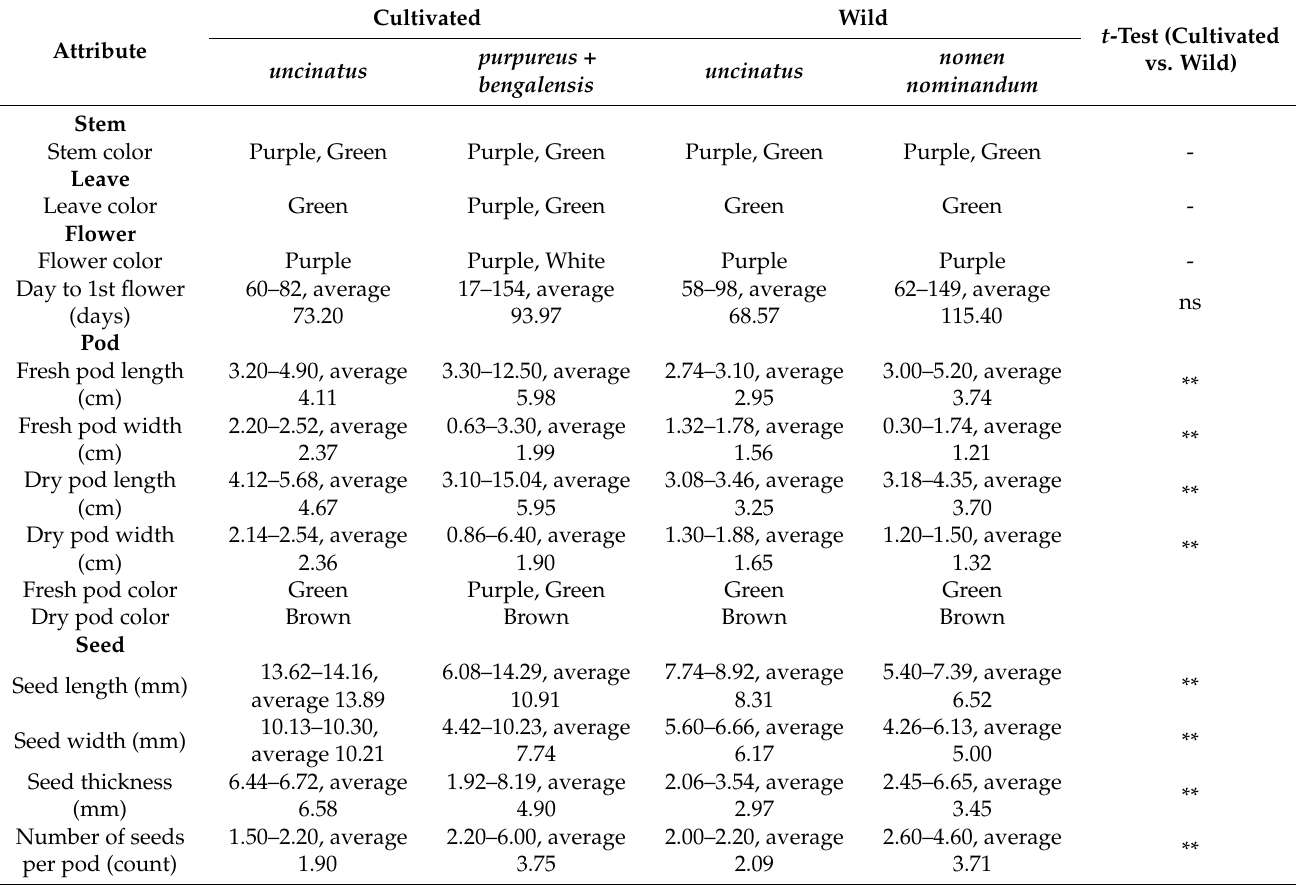
Table 1. Variation in 14 morphological traits in 493 lablab